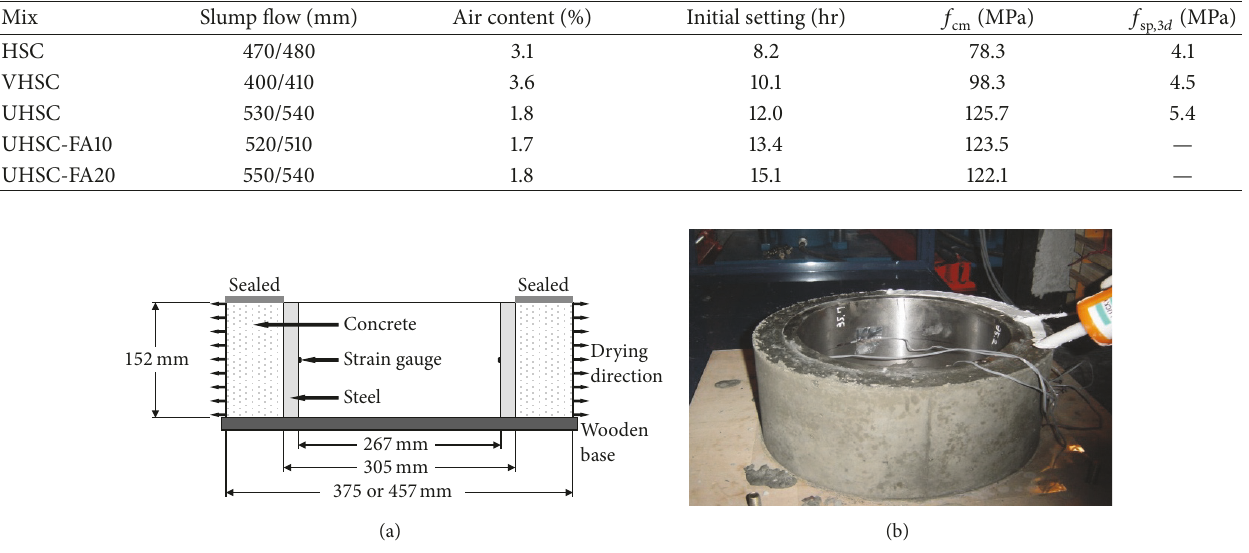
Figure 3: Ring test setup: (a) dimensions of ring test; (b) top sealing of ring specimen.